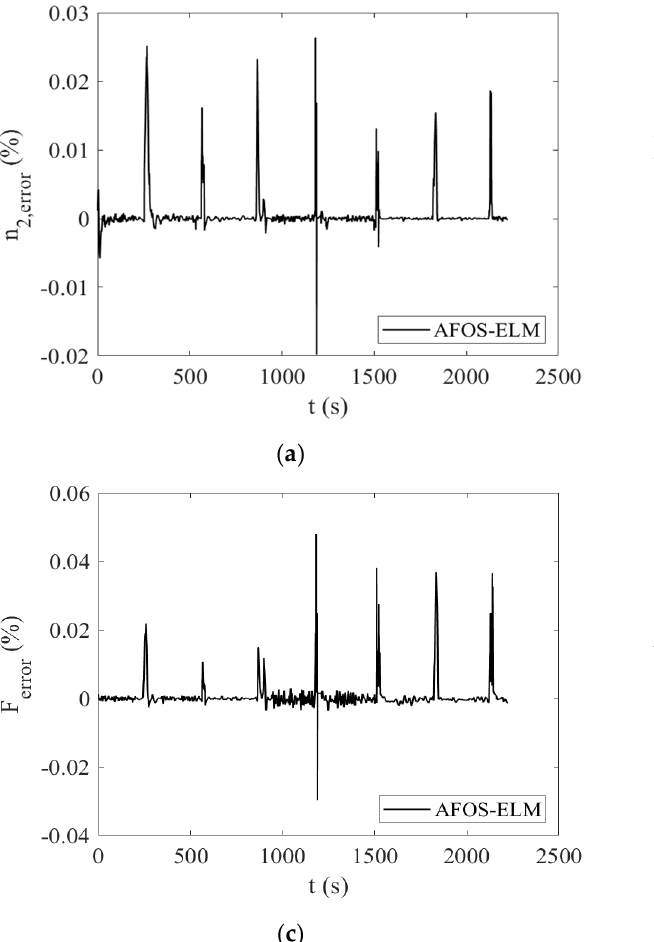
Figure 4. Comparison of relative error between AFOS-ELM and OS-ELM. ( a ) Error of AFOS-ELM n 2 ( k + 1) output; ( b ) error of OS-ELM n 2 ( k + 1) output; ( c ) error of AFOS-ELM F ( k + 1) output; ( d ) error of OS-ELM F ( k + 1) output.